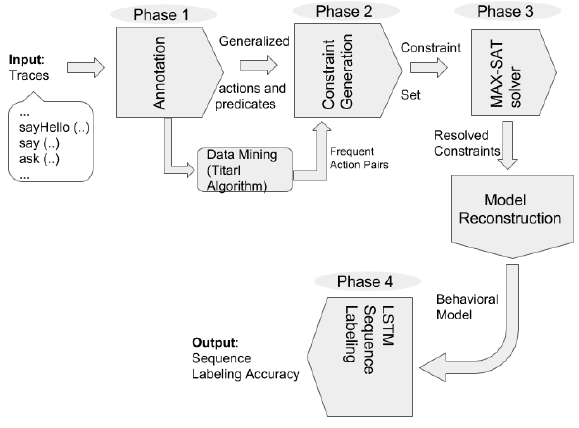
Figure 1: Approach phases.